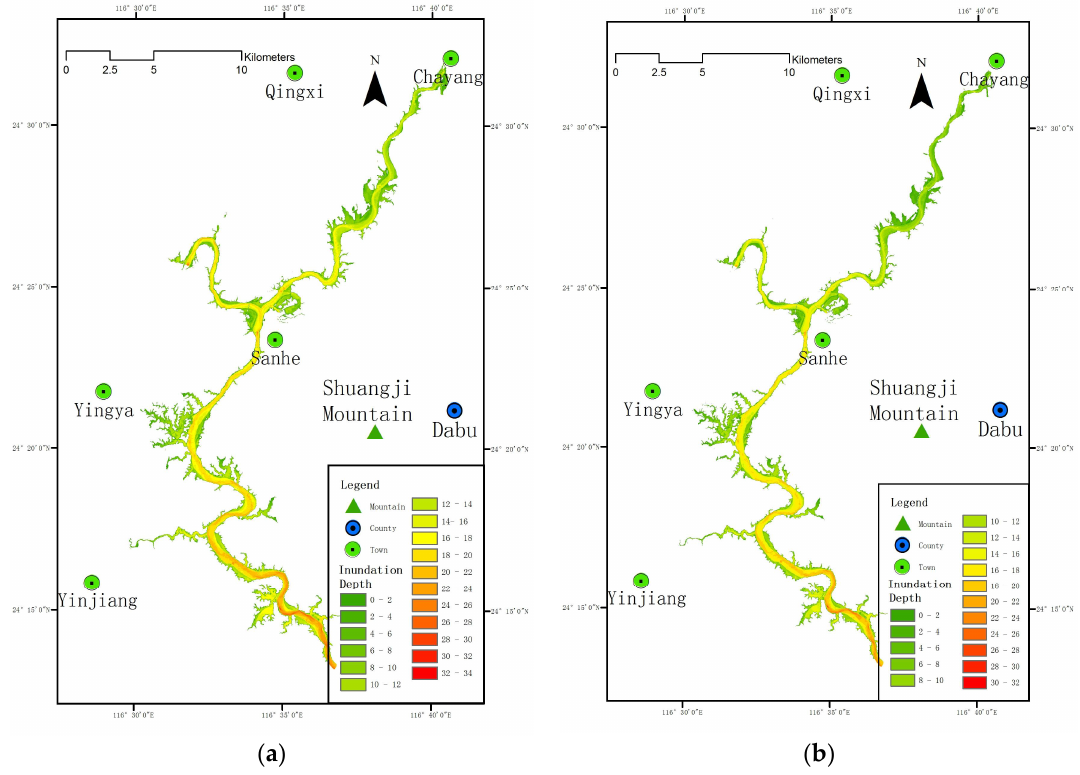
Figure 11. The flood inundation depth of different return periods. ( a ) The flood inundation depth of HQ 100 ; and, ( b ) The flood inundation depth of HQ 50 .